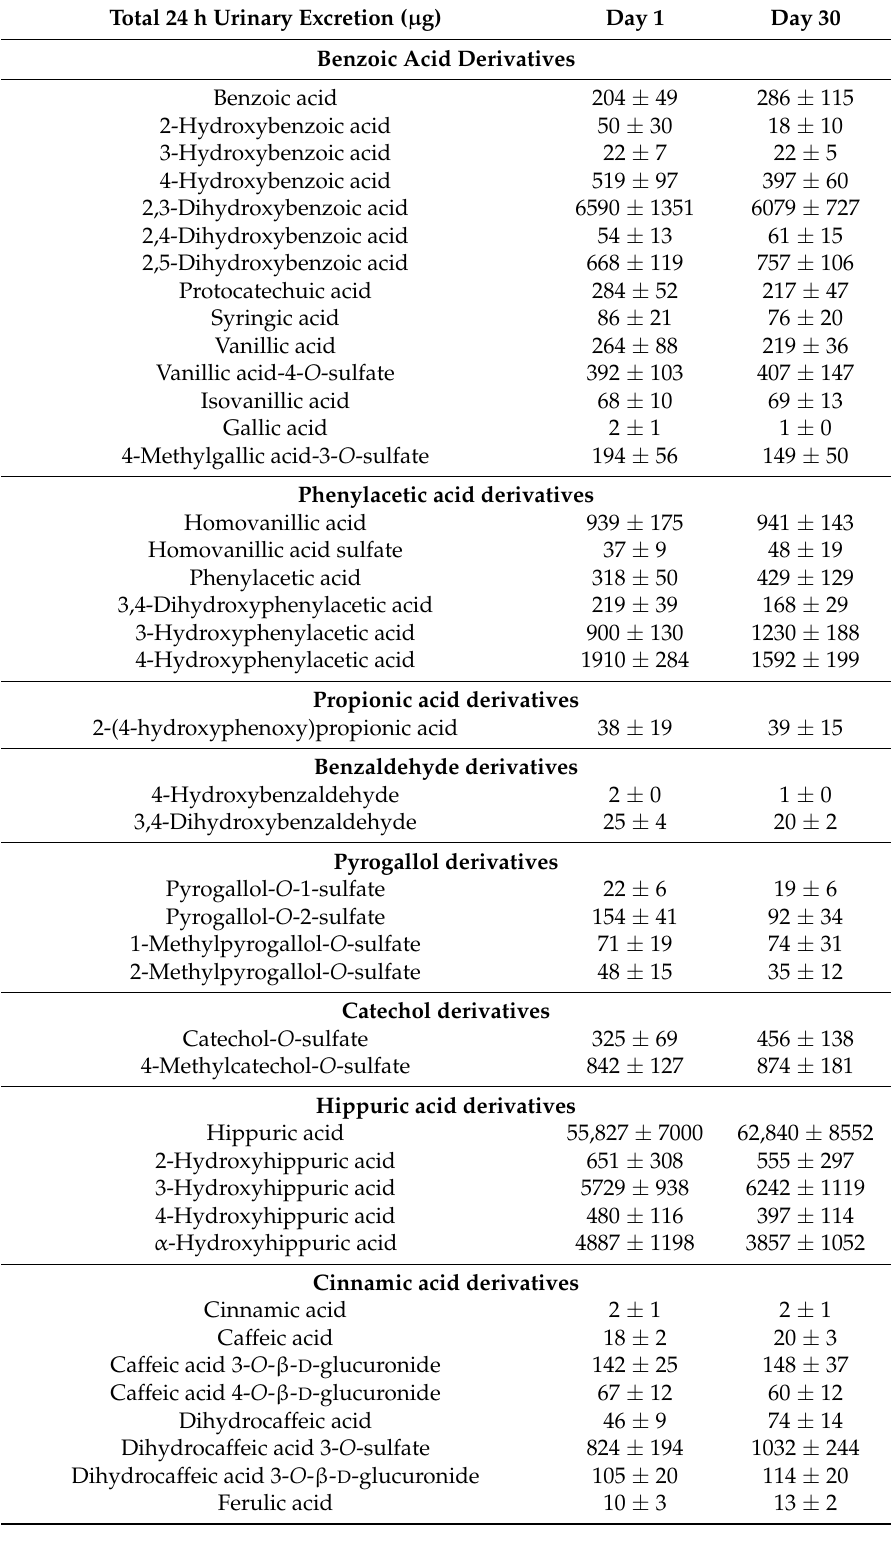
Table 3. Urinary excretion (24 h) after acute (day 1) and repetitive intake (day 30) of wild blueberries. Data is expressed as average ± SEM ( µ g). The % recovery (bold values at bottom) represent the percentage of the total amount of (poly)phenols ingested in the blueberry drink that were excreted in urine. No statistical significances were found between day 1 and day